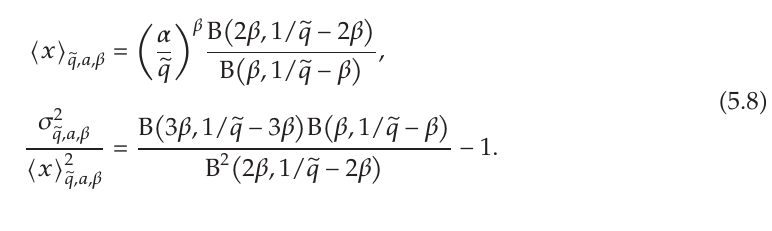
Particular values of β lead to a (cid:2) q -generalization of the error function and to the Zipf- Mandelbrot